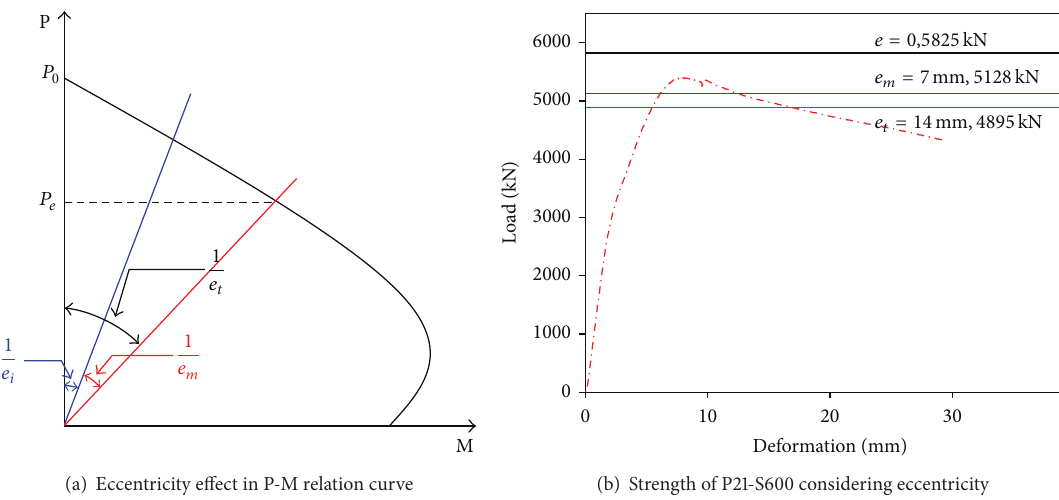
(b) Strength of P21-S600 considering eccentricity Figure 9: P-M interaction model considering the effect of